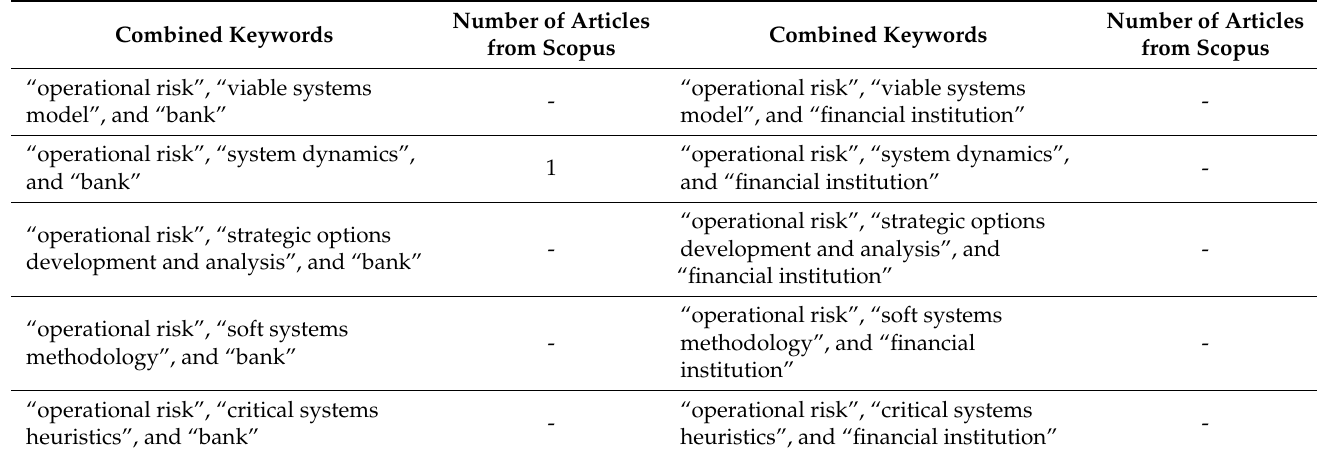
Table 2. Number of banking operational risk management studies applying systems thinking approaches identified from a literature review.